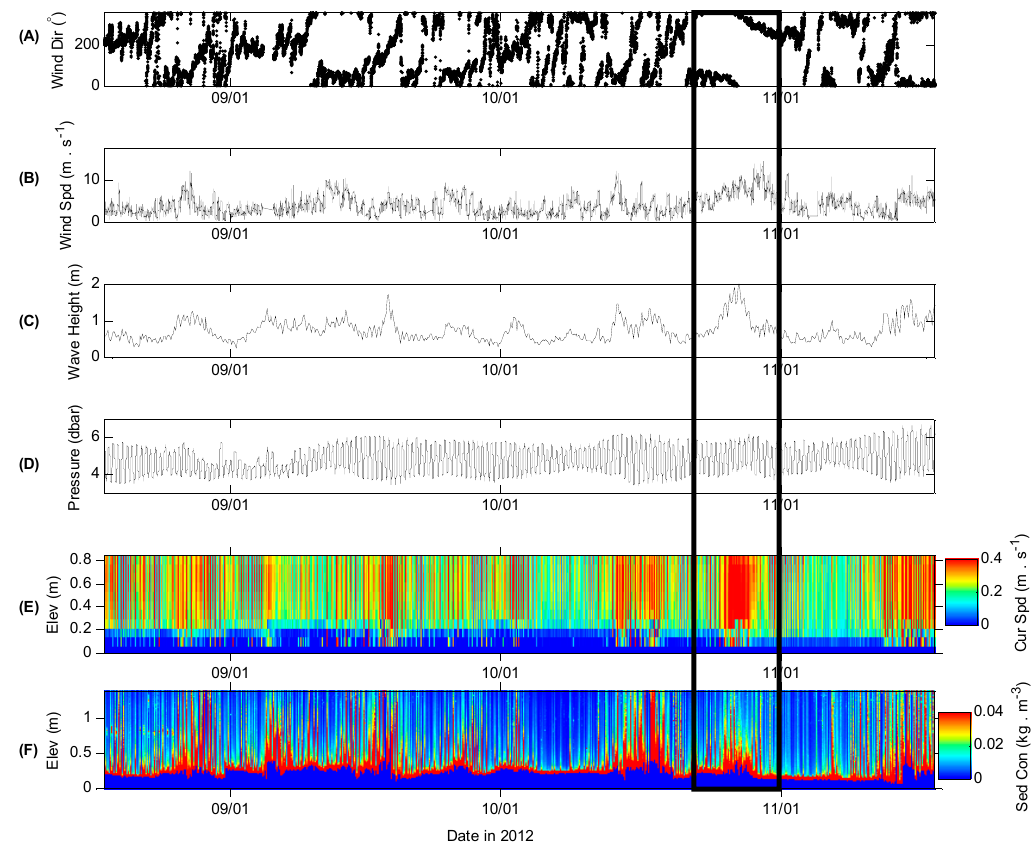
Figure 4. ( A ) Wind direction and ( B ) speed from Fort Pulaski, GA; panels ( C – F ) are data from reference site R1 collected between August 15 to November 17, 2012. ( C ) Wave height and ( D ) pressure are based on upward-looking AWAC. ( E ) Current speed is from downward-looking PCADP. ( F ) Suspended sediment concentration is from downward-looking ABS. The rectangle highlights the far-distance impact of Hurricane Sandy in late October 2012.